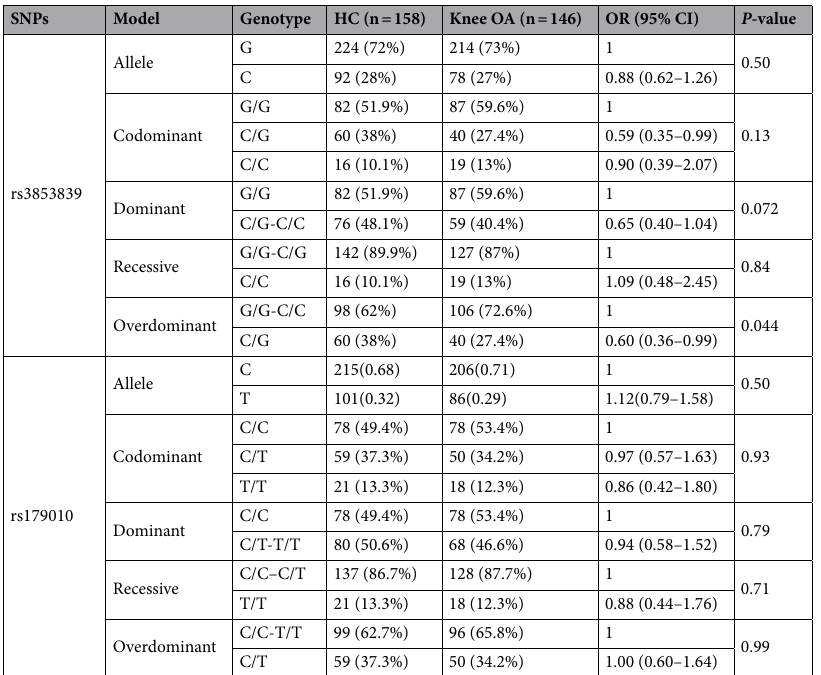
Table 4. Association analysis between SNPs and the female Knee OA risk under different models. Knee OA osteoarthritis patients group, HC healthy control group, OR odds ratios, CI confidence intervals. The data adjusted by smoke + drinking + age + BMI.